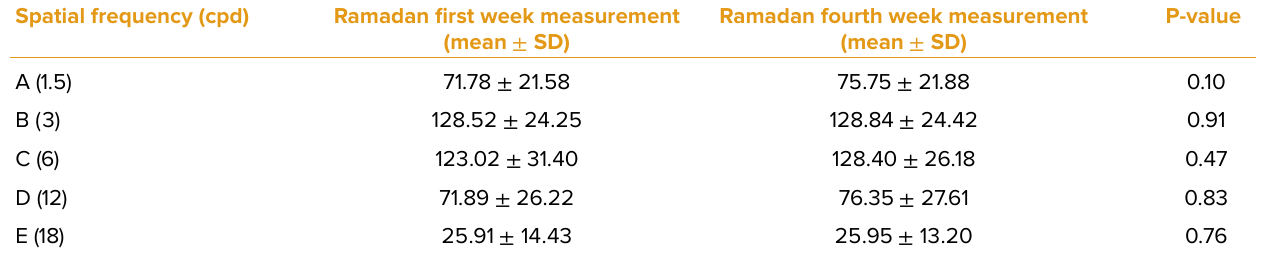
Table 4. The comparison of contrast sensitivity measurements conducted in the Ramadan 1st and 4th week Spatial frequency